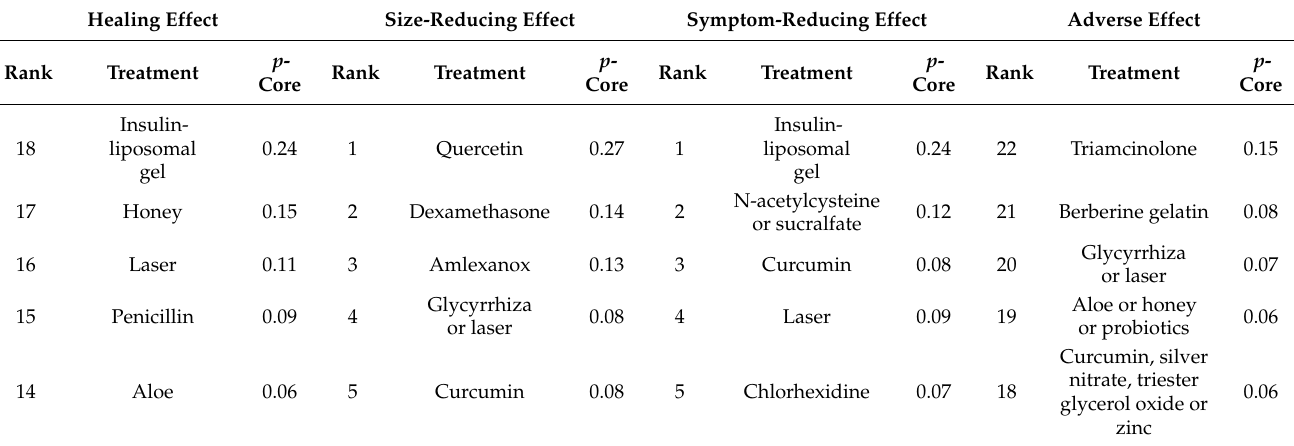
Table 2. Outcome p -cores for the best five